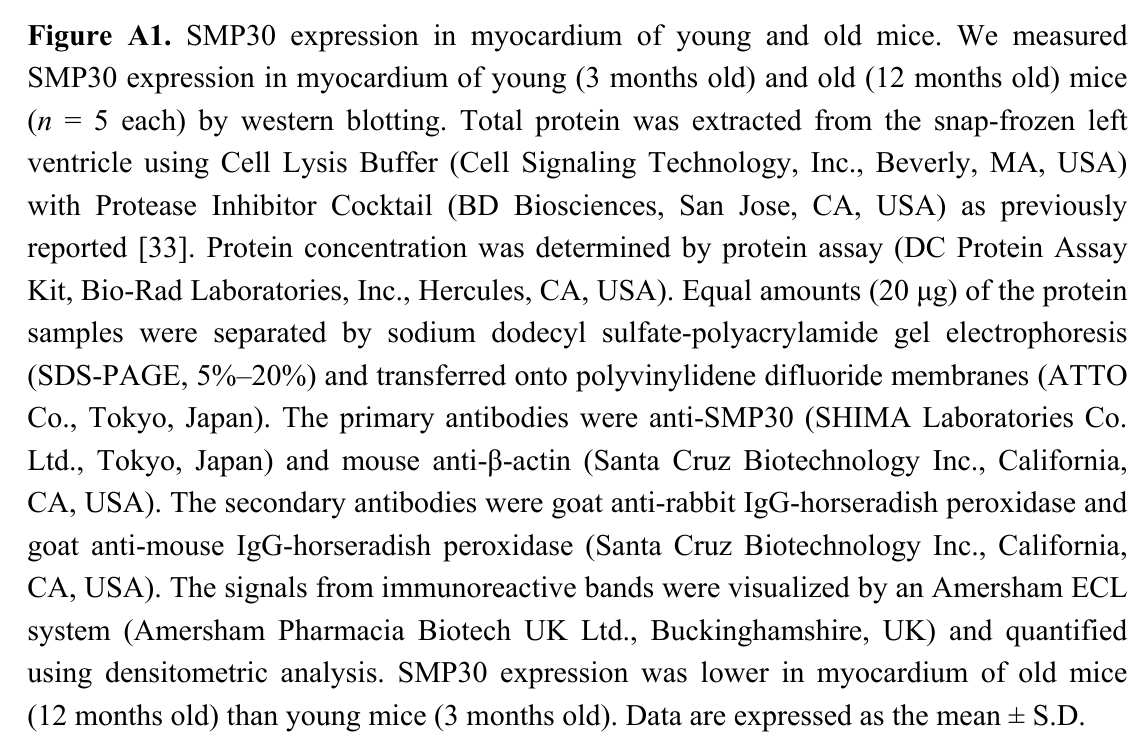
Figure A1. SMP30 expression in myocardium of young and old mice. We measured SMP30 expression in myocardium of young (3 months old) and old (12 months old)